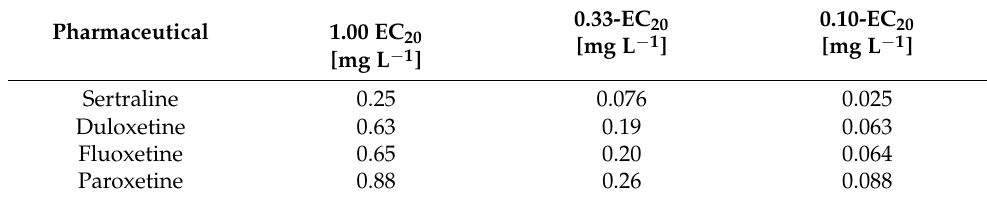
Table 1. The concentrations of the tested pharmaceuticals used in the ingestion assay.